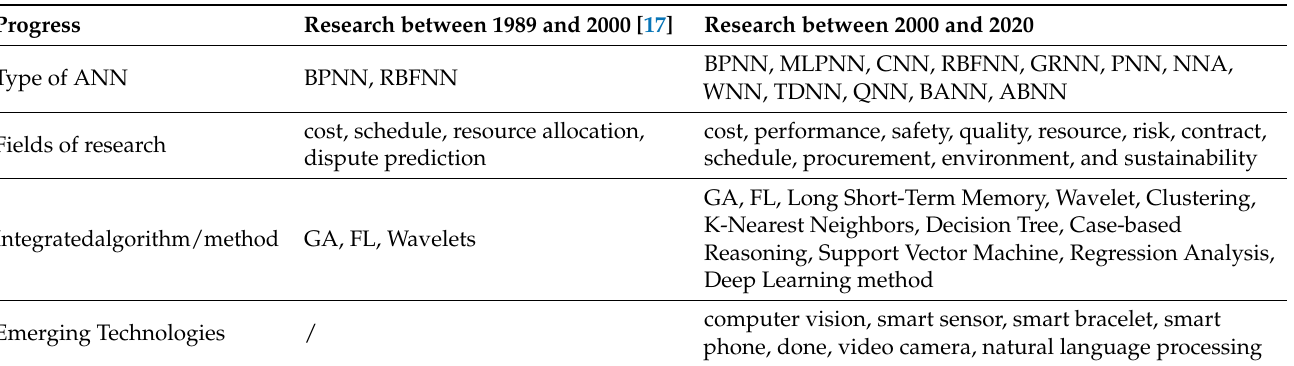
Table 7. Comparison of research progress.